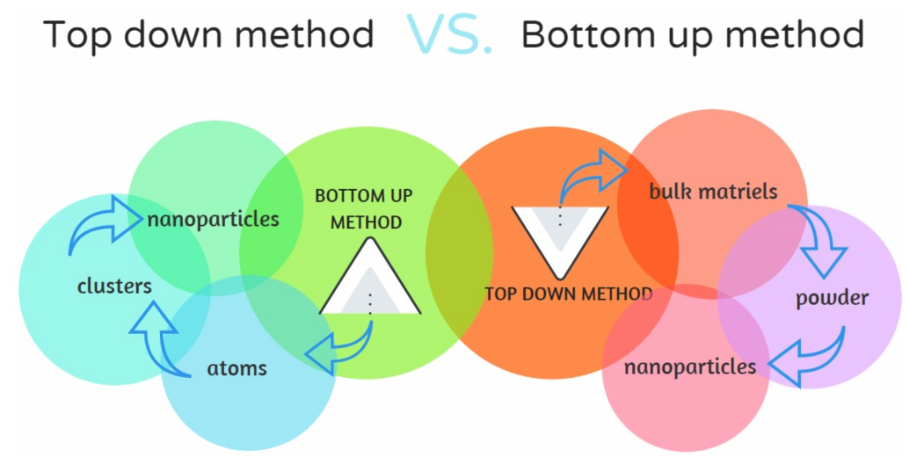
Figure 1. The difference between the bottom-up method and top-down